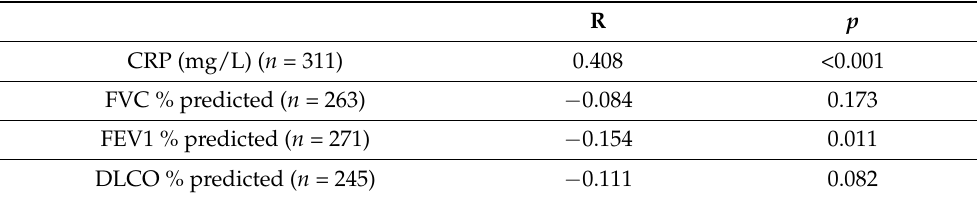
Table 2. Spearman’s rho correlations with